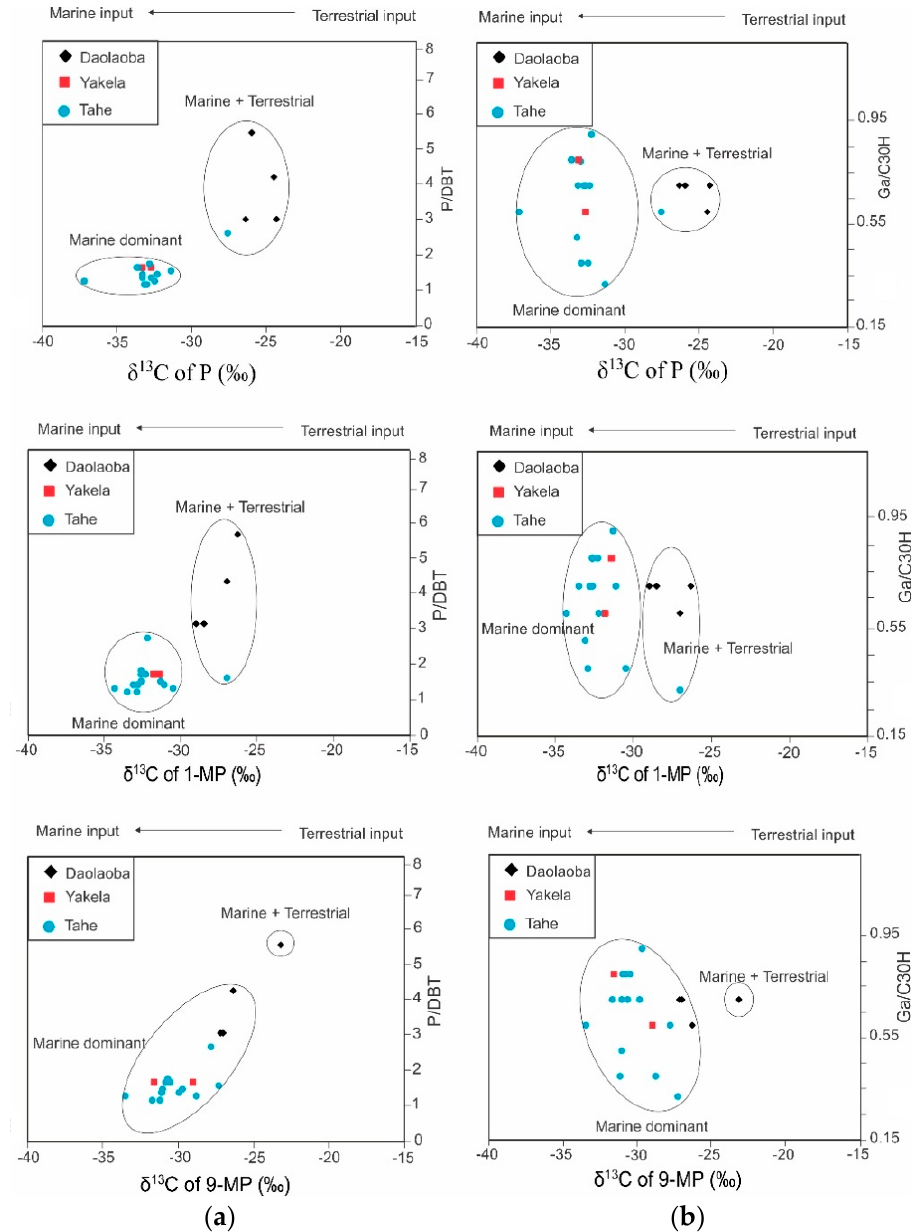
Figure 7. Plots of δ 13 C of P (phenanthrene), 9-MP, and 1-MP (MP: methylphenanthrene) versus ( a ) P/DBT (P: phe-nanthrene; DBT: dibenzothiophene) and ( b ) Ga/C 30 H (Ga: gammacerane; C 30 H: Hopane) ratios of 20 selected oils from Tarim Basin. Similar captions are used in Figures 6 and